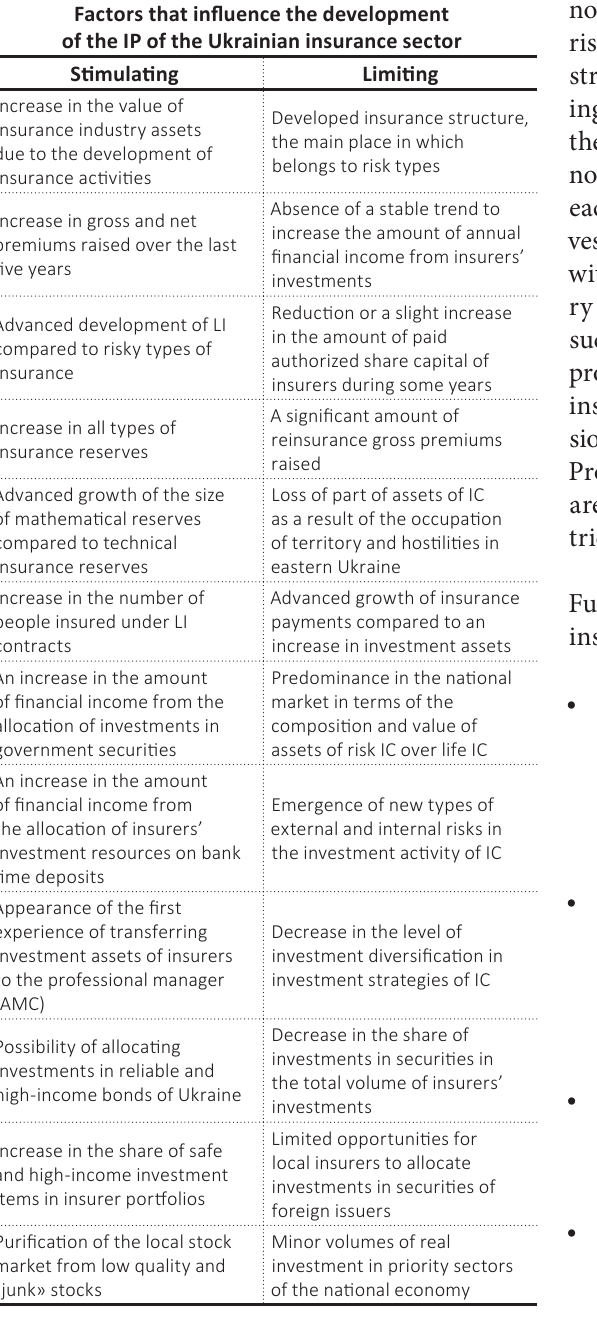
Table 4. Stimulating and limiting factors of IP development of the Ukrainian insurance